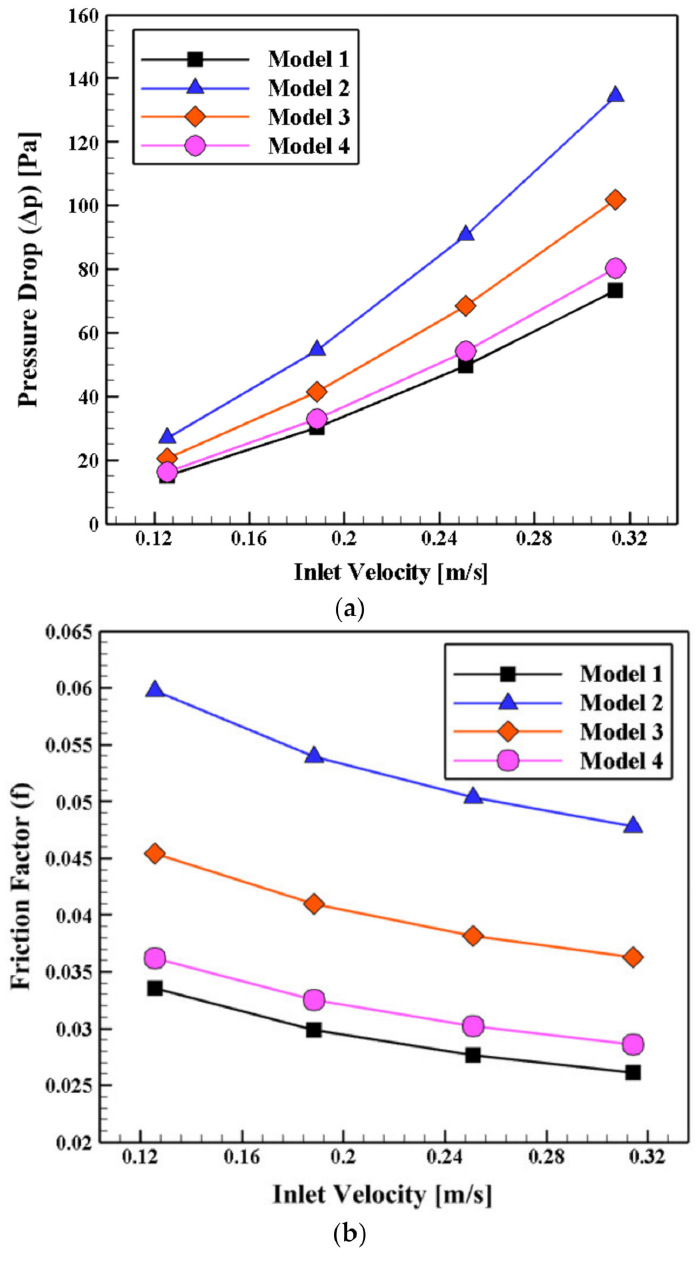
Figure 9. ( a ) Pressure drop and ( b ) friction factor variation with the inlet velocity for various models at P = 500